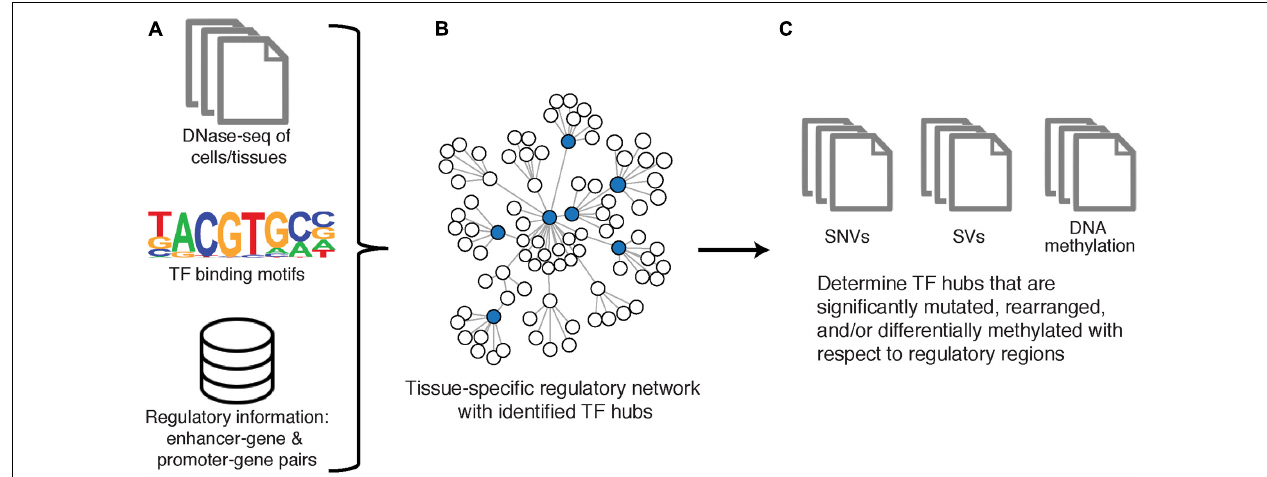
FIGURE 4 | RegNetDriver. (A) DNase-seq of DNase I hypermutation sites from a specific tissue type, information to identify TFs from binding motifs, and information of known regulatory gene pairs as used as input to reconstruct (B) a tissue-specific regulatory network. TF hubs are determined from nodes with the top 25% out-degree centrality. (C) Significantly perturbed TF hubs are identified using SNV, SV, and DNA methylation data.